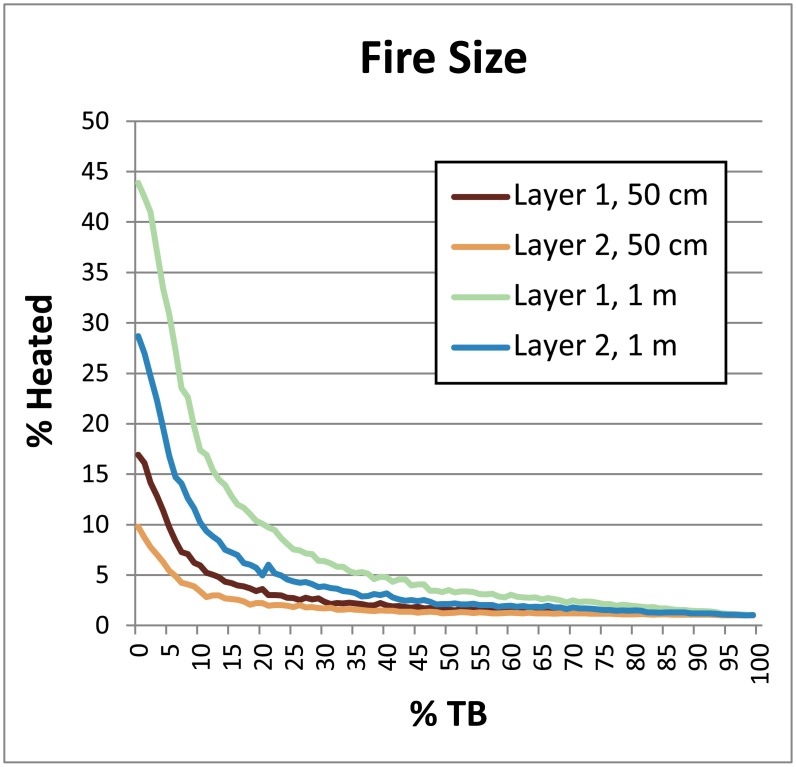
Chart demonstrating the effects of fire size on the percentage of heated lithics.Parameters: Fires Random/Lithic Scatters Random (FR/LSR), 1 fire, 4 lithic scatters, 0–100% TB, 1% introduced lithics. While a 1 m-wide fire (fire size 4) is effectively a cluster of four 50 cm-wide hearths (fire size 1) in our model, note the slightly lower relative percentages compared to four individually placed 50 cm-wide hearths in Fig 9.